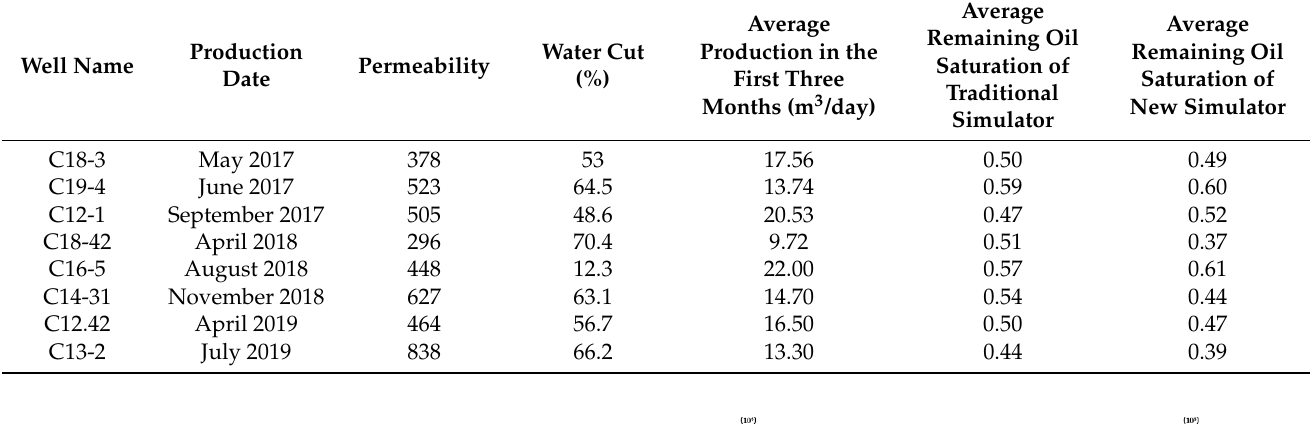
Figure 11. The average remaining oil saturation distribution (the left one is calculated by a traditional simulator, the right one is calculated by the new simulator). Table 3. The first production of deployed production wells since 2017.